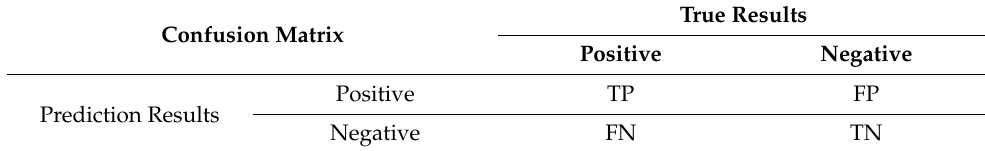
Table 3. Confusion Matrix. True Results Confusion Matrix Positive Negative Positive Prediction Results Negative